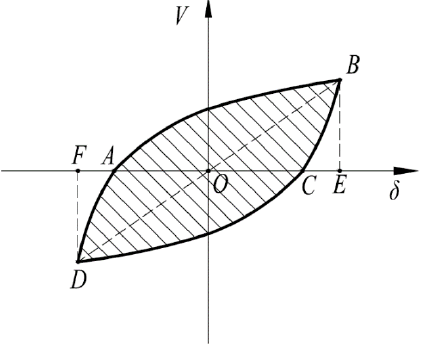
Figure 13. Definition of the energy dissipation coefficients.